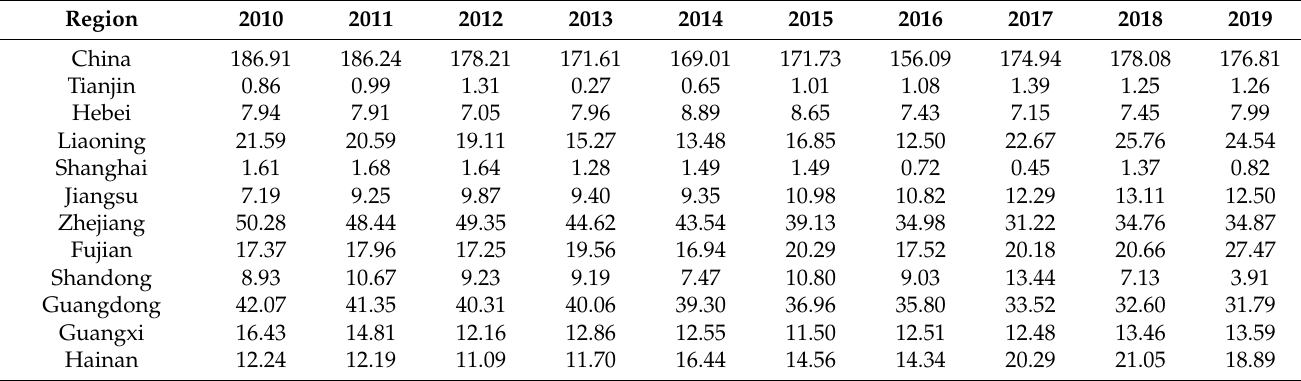
Table 1. Net carbon emissions from China’s offshore fishing industry in 2010–2019 (10 4 t).